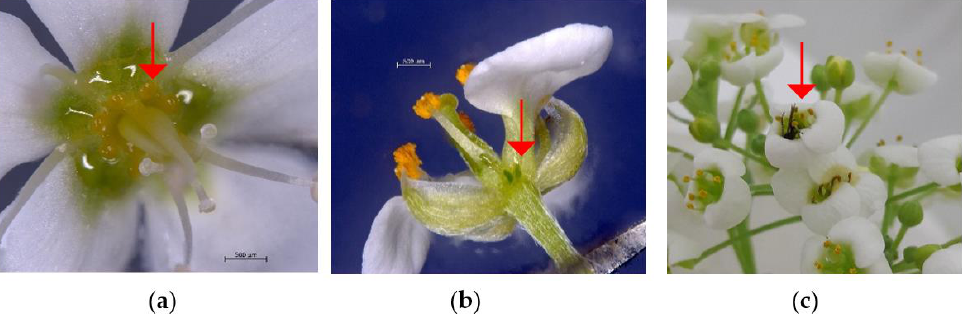
Figure 5. ( a ) Habitus of buckwheat flower with yellow-coloured nectaries (arrow), scale bar = 500 µm, ( b ) Habitus of alyssum flower with green nectaries (arrow), scale bar = 200 µm, ( c ) T. drosophilae -male (arrow) crawling into the alyssum flower.